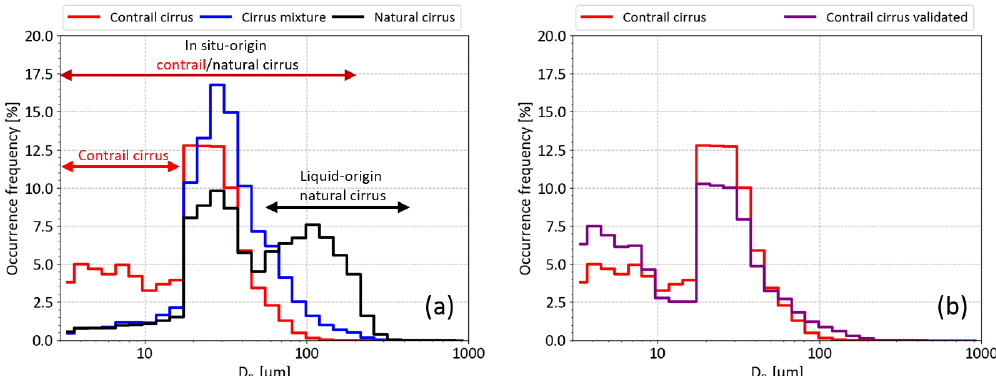
Figure 6. (a) Normalized occurrence frequency of ice particle sizes in diameter ( D p , unit: µm) in the contrail cirrus (red), cirrus mixture (contrail cirrus, in situ- and liquid-origin natural cirrus, blue), and natural cirrus (black). The ice particle size ranges for contrail cirrus, in situ-origin contrail or natural cirrus, and liquid-origin cirrus are marked by the arrows. (b) Similar to (a) but for contrail cirrus (red) and contrail cirrus satisfying the Schmidt–Appleman criterion (SAC) and validated with the aircraft exhaust plume detection method (purple). Note that D p stands for optical-equivalent diameter for NIXE-CAS-DPOL in the size range of 3–17µm and area-equivalent diameter for NIXE-CIPg in the sizes greater than